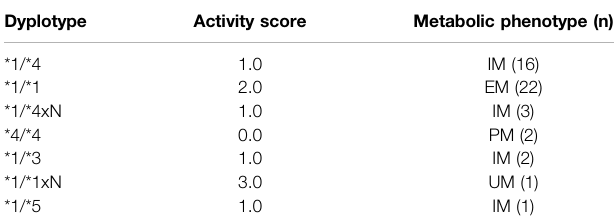
TABLE 2 | CYP2D6 diplotype, assigned activity score, and metabolic phenotype. PM, poor metabolizer; IM, intermediate metabolizer; EM, extensive metabolizers; UM, ultrafast